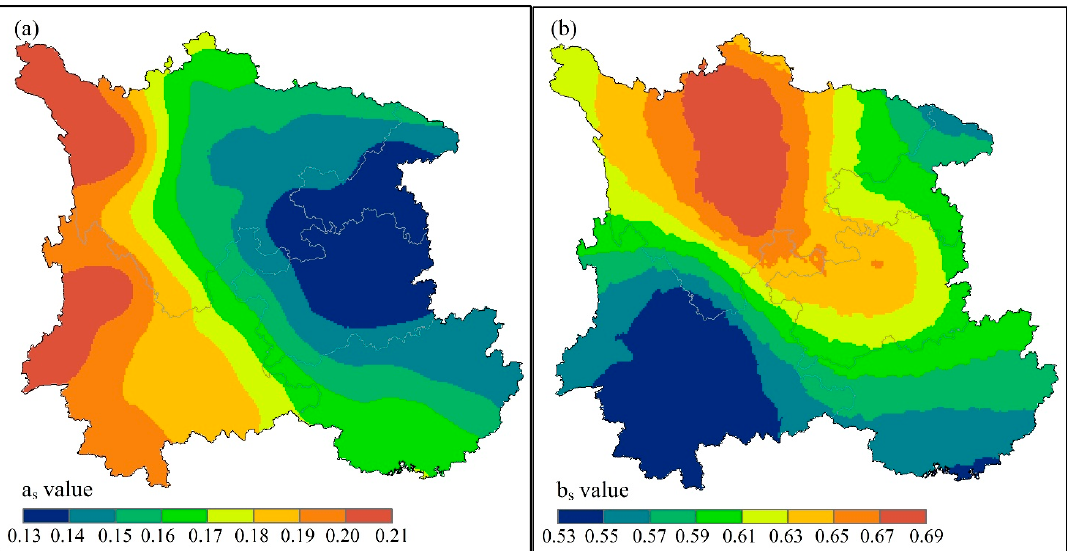
Figure 3. Spatial pattern of optimized annual average a s and b s for calculating solar radiation in Southwest China from 1993 to 2015. ( a ) The distribution of parameter of optimized a s and ( b ) b s .